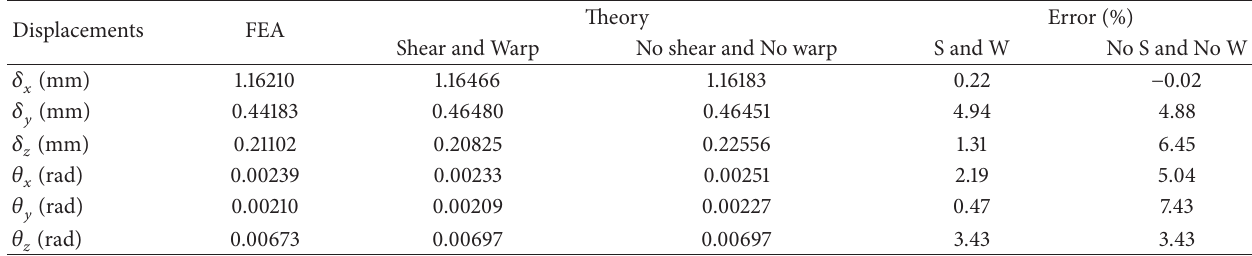
Table 1: Comparison between theory and the FEA at the default values of the SBLF.